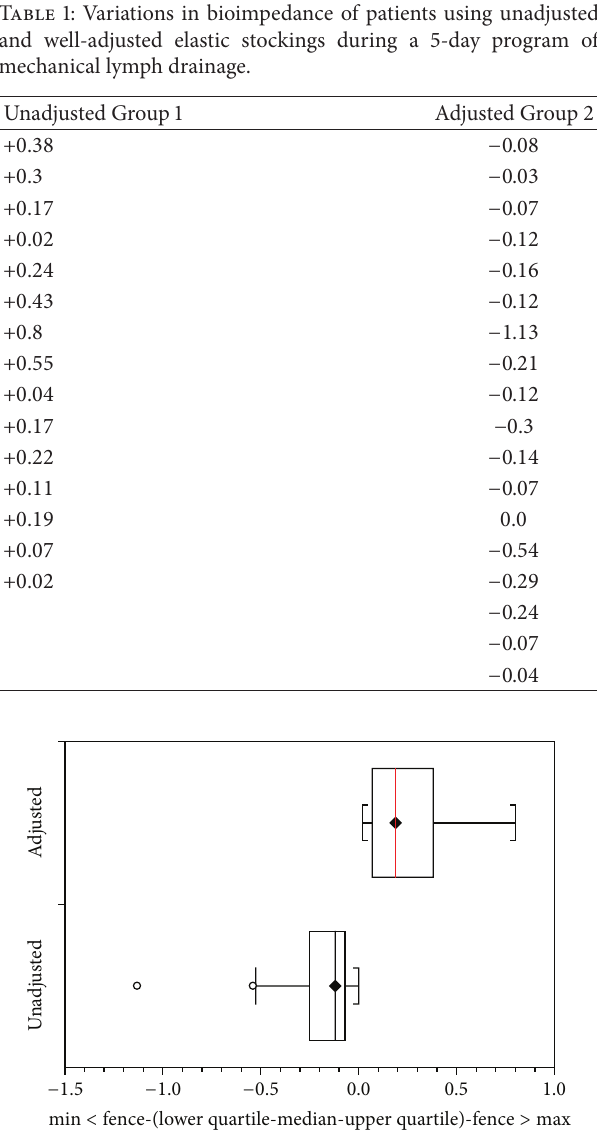
Figure 1: Box and whisker plot 1 shows changes in volume before and after treatment of lymphedema evaluated by bioimpedance in stockings adjusted and